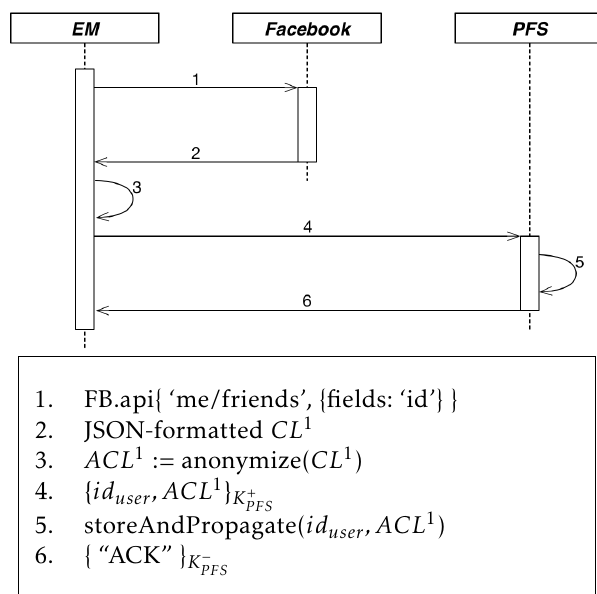
Figure 7. Registration phase: messages Exchange User